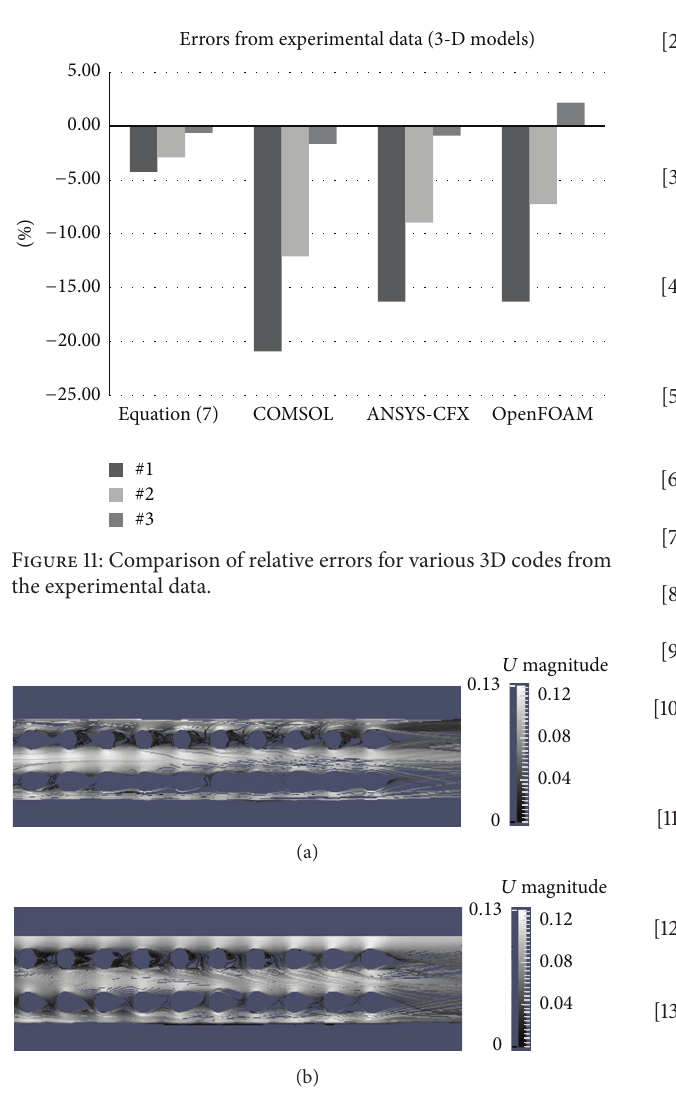
Figure 12: Comparison of wake flow field in the streamlines for Case 1, OpenFOAM with (a) laminar, or no turbulence model, and (b) 𝑘 - 𝜀 turbulence